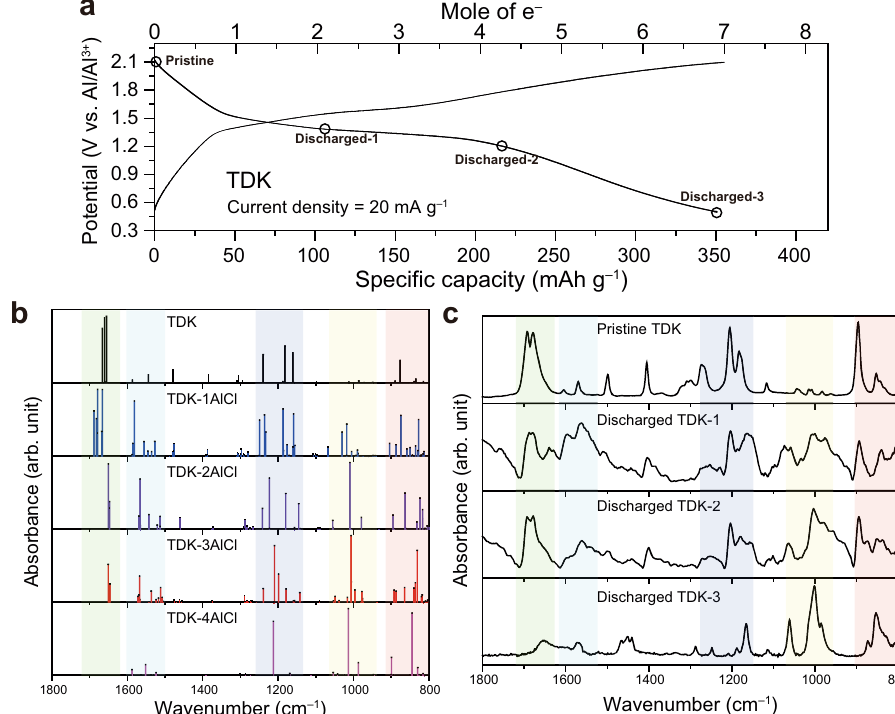
Fig. 3 Ex situ FT-IR characterisation of TDK. a Galvanostatic voltage pro fi les of TDK at the current density of 20 mA g − 1 . b Calculated IR vibration peaks of TDK when bound with AlCl 2 + ions. c Measured FT-IR absorbance spectra of the TDK electrode. The discharging points at which the measurements were carried out are indicated in ( a